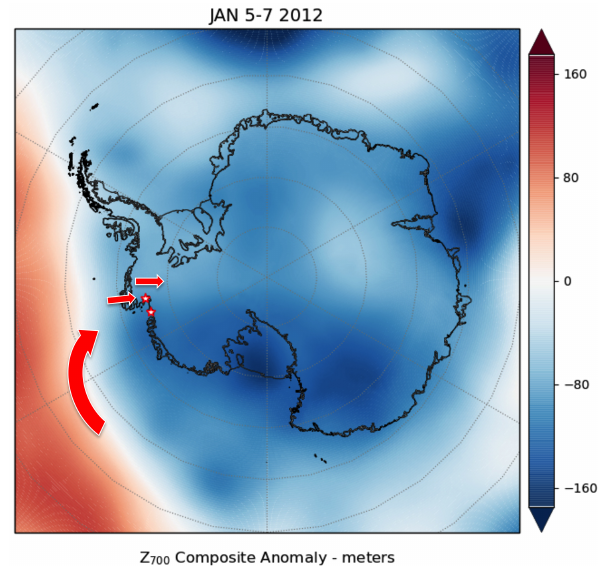
Figure 6. Composite anomaly of ERA5 700hPa geopotential height for 5–7 January 2012. The red stars depict the locations of Pine Island and Thwaites glaciers. The red arrows depict the direction of 700hPa winds relevant to the case